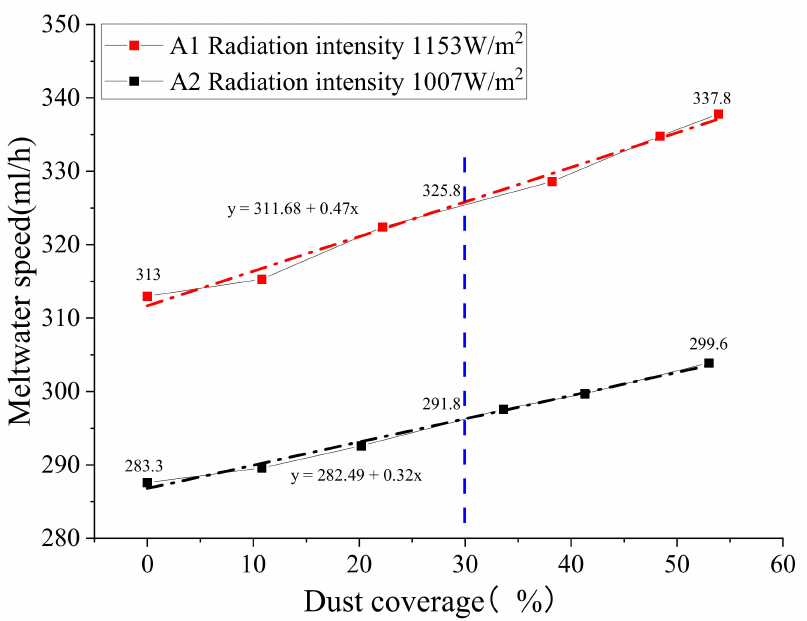
Figure 6. Relationship between the dust coverage rate and meltwater speed (Group A), chain dotted lines are fitted curves of experimental data (same as figures below).